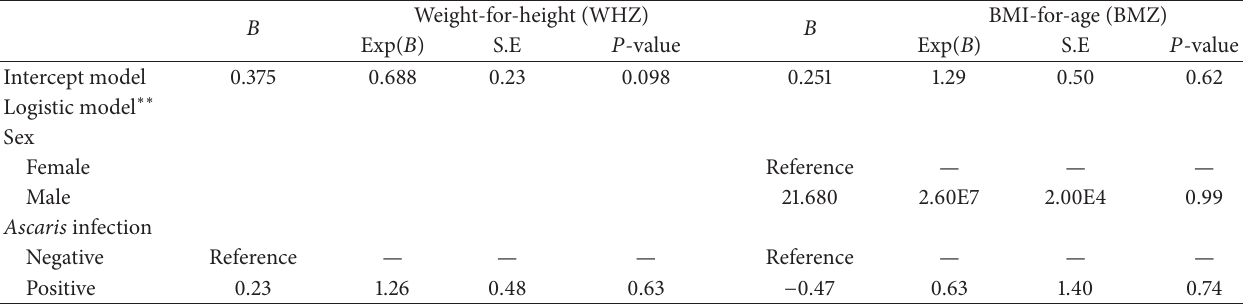
Table 12: Logistic regression models for malnutrition